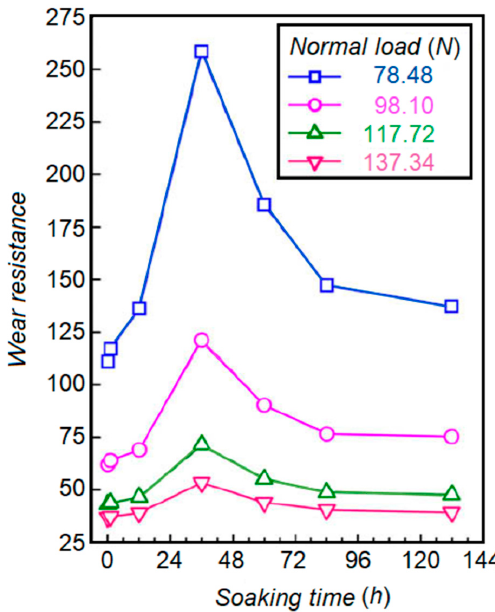
Figure 6. Influence of soaking time on the wear resistance of cryo-treated D2 steel specimens [63]. Straffelini et al. optimized the wear resistance of stamping tools applicable to the automotive industry [64]. The effects of three treatments were examined: coating by thin ceramic film (AlCrN) using physical vapor deposition (PVD), a tool produced by hard metal, and two DCT treated HSS (high-speed steel). DCT improves the wear resistance of the tool as a result of the precipitation of ultrafine carbide